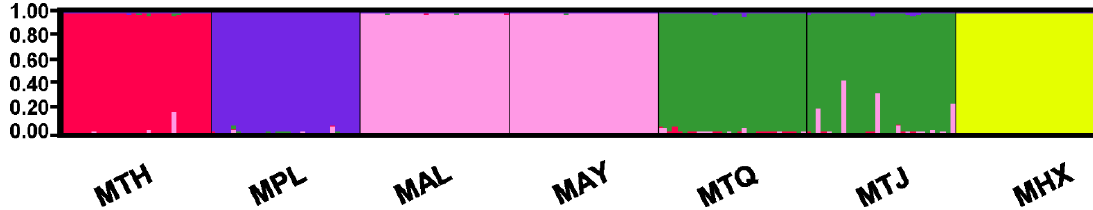
Figure 4. Structure analysis of 7 populations from the genus Megalobrama based on sequence-related amplified polymorphism (SRAP) markers. Each color represents a special cluster, and each individual is represented by a vertical line. MTH, M. terminalis in the Heilong River; MTQ, M. terminalis in the Qiantang River; MTJ, M. terminalis in the Jinsha River Reservoir; MPL, M. pellegrini in the Longxi River; MAL, M. amblycephala in the Liangzi Lake; MAY, M. amblycephala in the Yi River and MHX, M. hoffmanni in the Xi River.